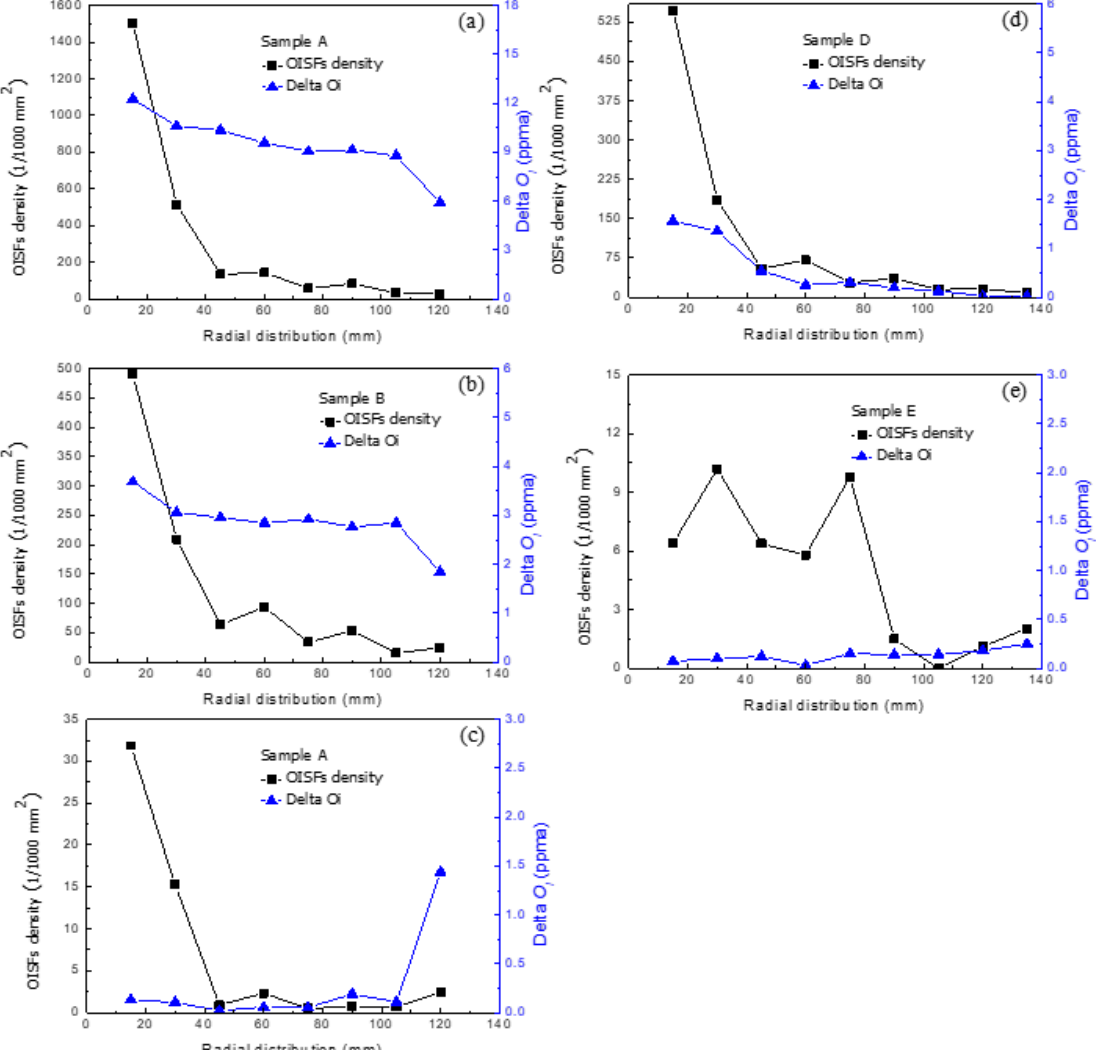
Figure 5. Relationship between the difference in oxygen concentration (delta O i ) and the radial distribution of the OISF. Delta O i is obtained from FTIR measurements before and after a high- temperature wet oxidation. ( a – e ) are samples A, B, C, D, and E,